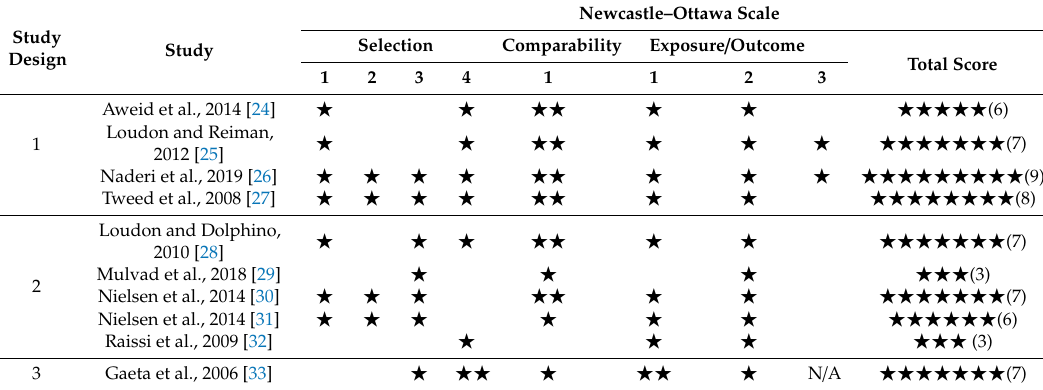
Table 2. Newcastle–Ottawascale scores for observational studies.